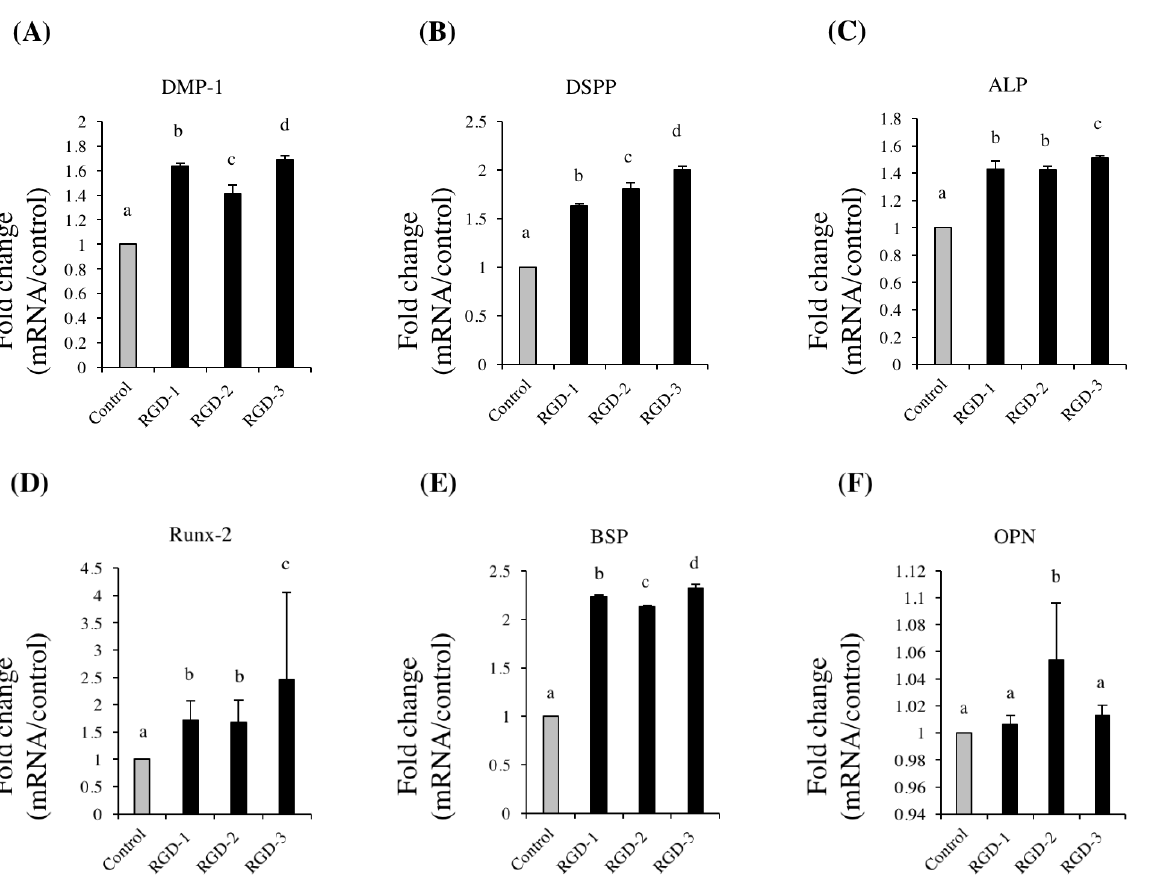
Figure 4. Effects of RGD peptides on the mRNA expression of odontogenic differentiation markers. hDPSCs were spread onto non-TCPP plates coated with 1 M RGD peptides (RGD-1, RGD-2 and RGD-3) or dH 2 O (control). Real time RT-PCR was performed on day 21. The mRNA expression of hDMP-1 ( A ), hDSPP ( B ), hALP ( C ) and hBSP ( E ) was significantly upregulated by RGD peptides. The differences in hRunx-2 ( D ) and hOPN ( F ) mRNA expression were less evident. n = 3, different lowercase characters denote significant differences compared to the control ( p < 0.05 vs. control).